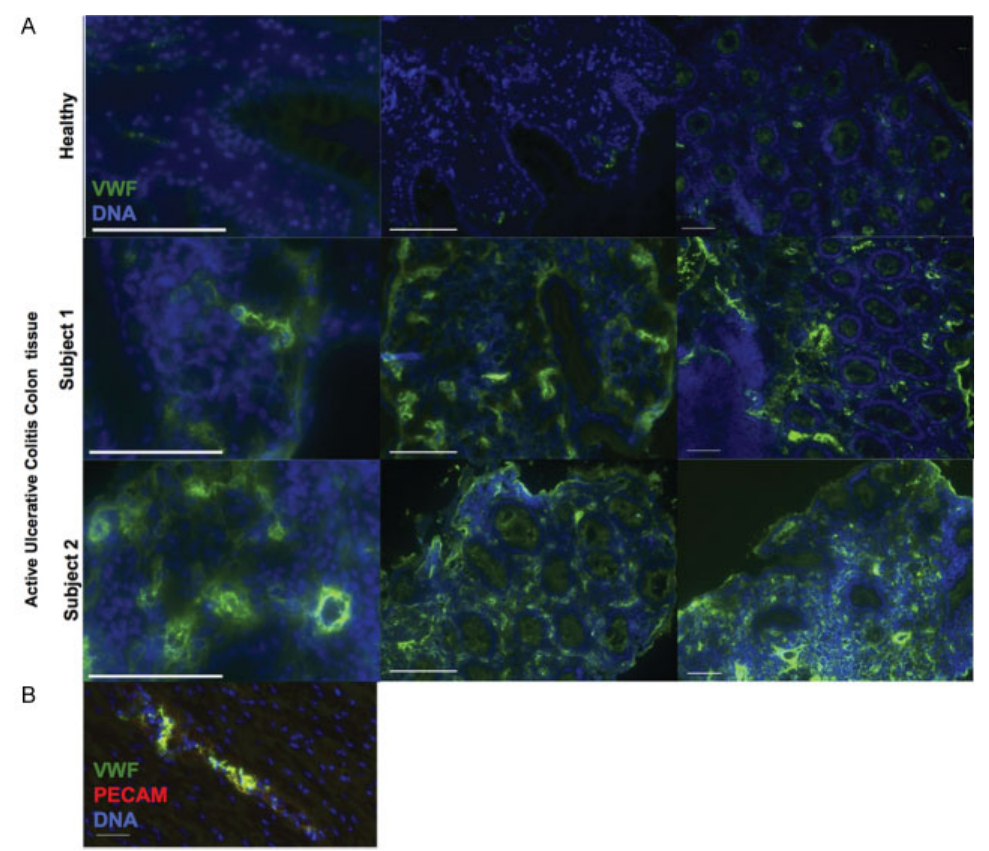
Fig. 5 Elevated VWF staining was seen in human colitis colon tissue. ( A ) Human colon tissue stained for VWF (green) and DNA (blue) shown at various magni fi cations. The top row is healthy colonic tissue with minimal VWF staining only within vessels. The second and third rows are samples from two different subjects with active ulcerative colitis (UC) and reveal increased VWF release surrounding vessels and deeper in colonic tissue. ( B ) A submucosal vessel (likely representing a thrombus) from a patient with UC cut longitudinally showing retained VWF (green) inside the vessel surrounded by endothelial cells stained for PECAM-1 (red). DNA (blue) stains all cells and shows the surrounding muscularis mucosa. Bar ¼ 50 μ